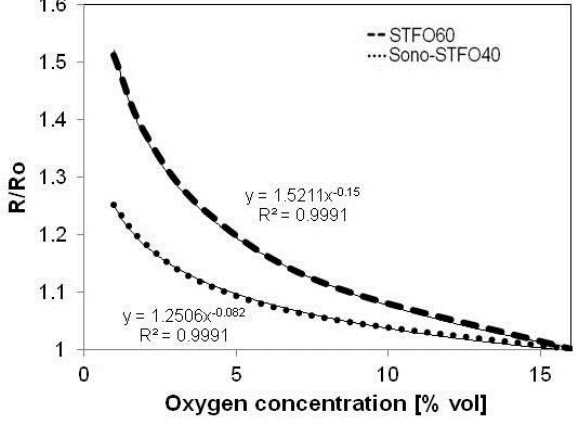
Figure 7. Normalized resistance vs. oxygen concentration for both Sono-STFO40 and